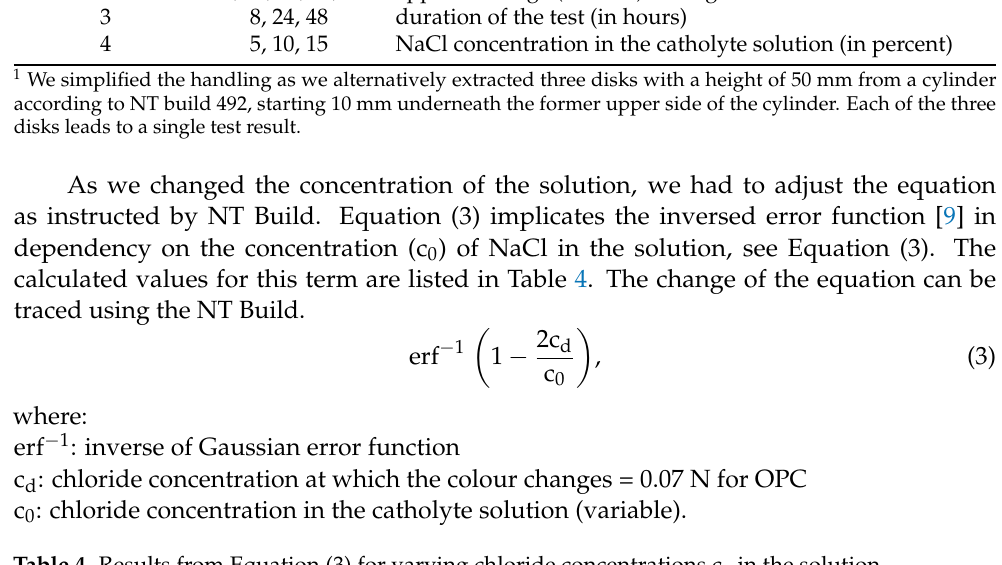
Table 4. Results from Equation (3) for varying chloride concentrations c 0 in the